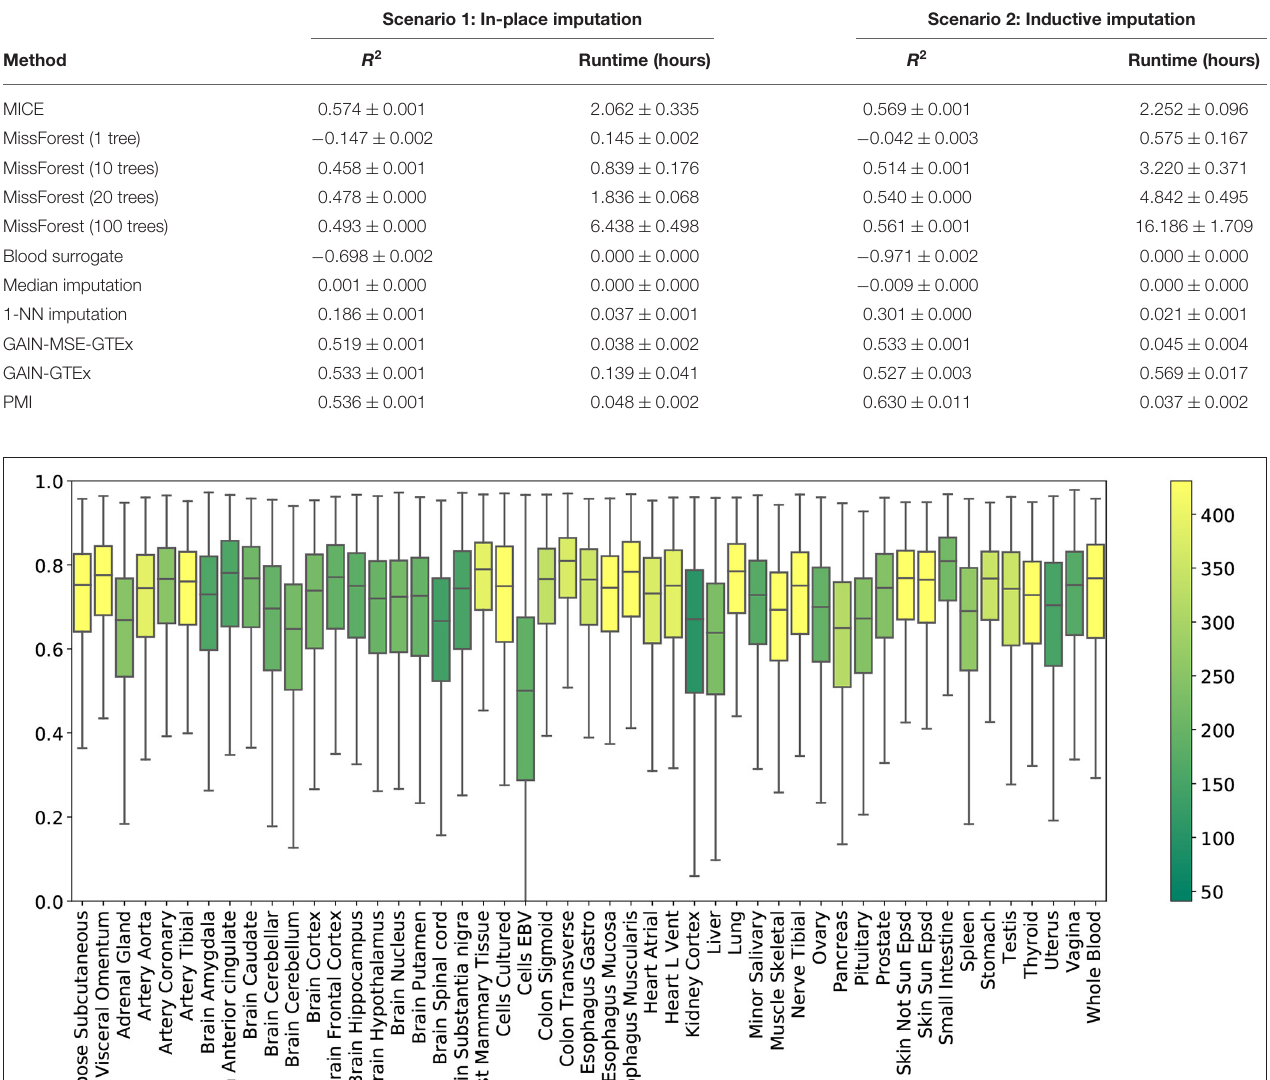
TABLE 2 | Gene expression imputation performance with a missing rate of 50% across 3 runs (for a subset of 273 genes from the Alzheimer’s disease pathway).